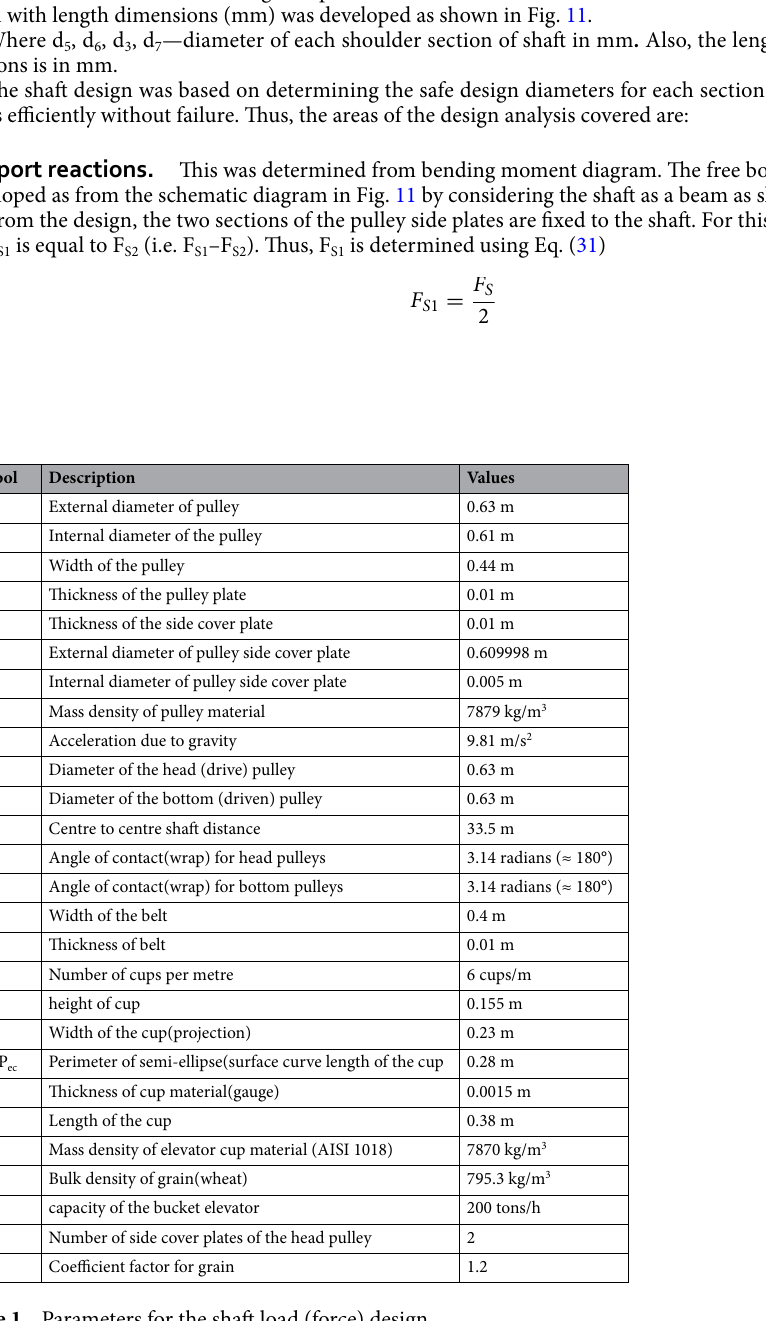
Table 1. Parameters for the shaft load (force)